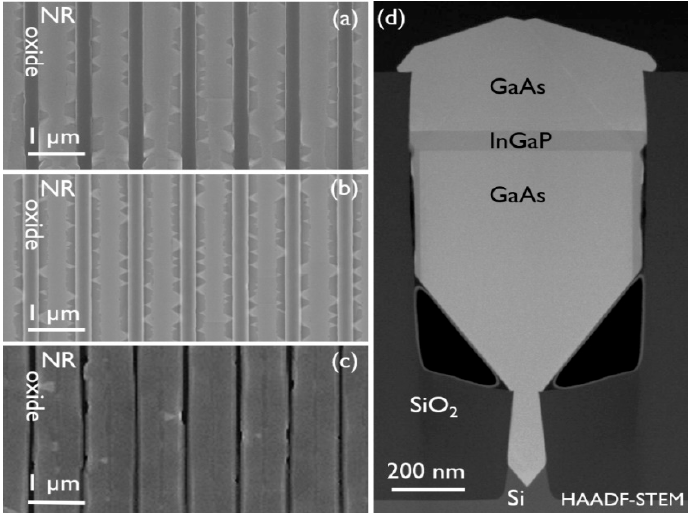
Figure 6. Top-view SEM images of NRs with a single thin InGaP layer ( a ) grown at 590 °C with double growth rate, ( b ) grown at 590 °C with In mole fraction of 0.68 and ( c ) grown at 500 °C. ( d ) Cross-section HAADF-STEM image of the sample shown in ( c ).